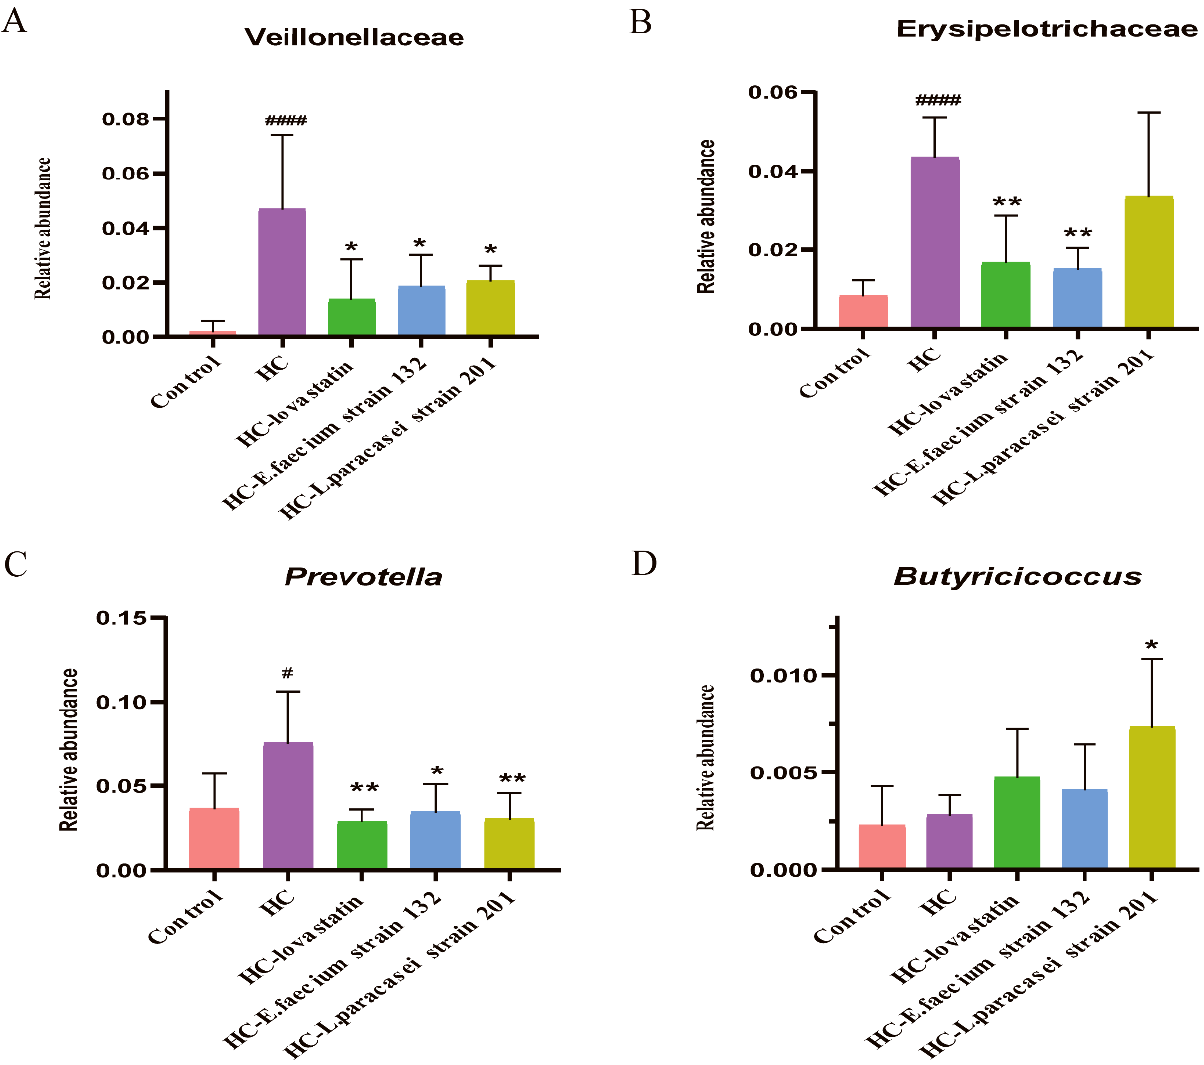
Figure 6. The relative abundance of Veillonellaceae, Erysipelotrichaceae, Prevotella and Butyricicoccus . ( A ) The relative abundance of Veillonellaceae; ( B ) The abundance of Erysipelotrichaceae; ( C ) The relative abundance of Prevotella ; ( D ) The relative abundance of Butyricicoccus . p -values were determined using a one-way ANOVA with Tukey’s test for post-hoc analysis, n = 6. Significant differences between the HC group versus control group are indicated as # p < 0.05, #### p < 0.0001. Significant differences in the HC-lovastatin, HC- E. faecium strain 132 or HC- L. paracasei strain 201 group versus HC group are indicated as * p < 0.05, ** p < 0.01.